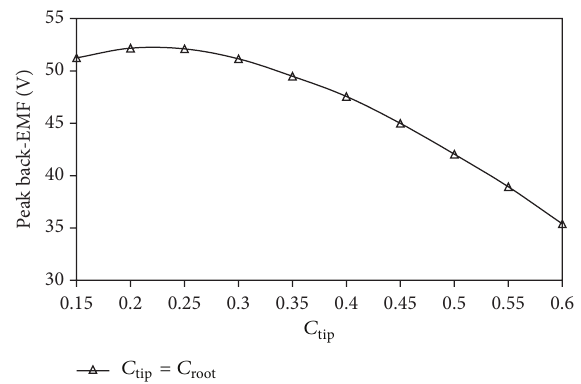
Figure 4: Peak value of back-EMF with respect to 𝑐